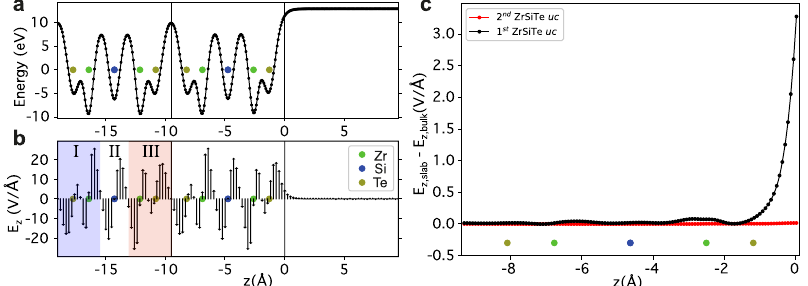
Fig. 8 Bulk and surface electric fi eld. a Electrons potential energy calculated for the two top-most unit cells of the slab as a function of the z -axis, orthogonal to the sample surface. b Corresponding electric fi eld, E z , represented by arrows. The shaded areas in sectors I and III indicate where the average value of 0.7 V/ Å is computed. c Difference between E z calculated in the fi rst (black line) and second (red line) unit cell of the slab with respect to the result of the bulk calculations and plotted as a function of the z axis. The surface contribution of E z is localized in a shallow region of ~1 Å , close to the sample